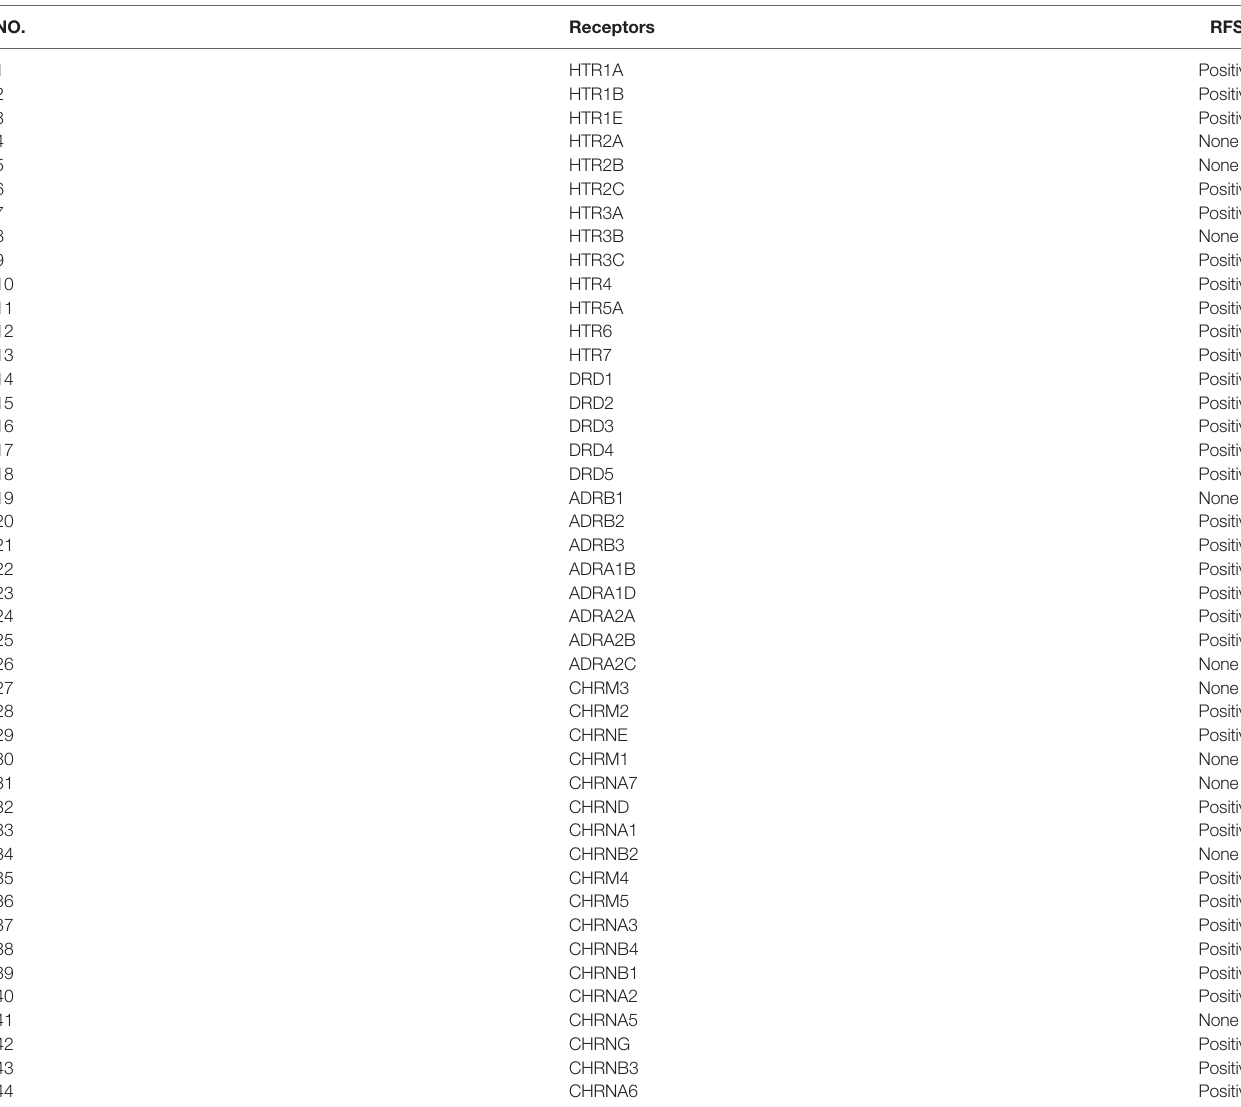
TABLE 1 | The analysis of the expression of 44 neurotransmitter receptors on RFS of breast cancer (n = 3951).